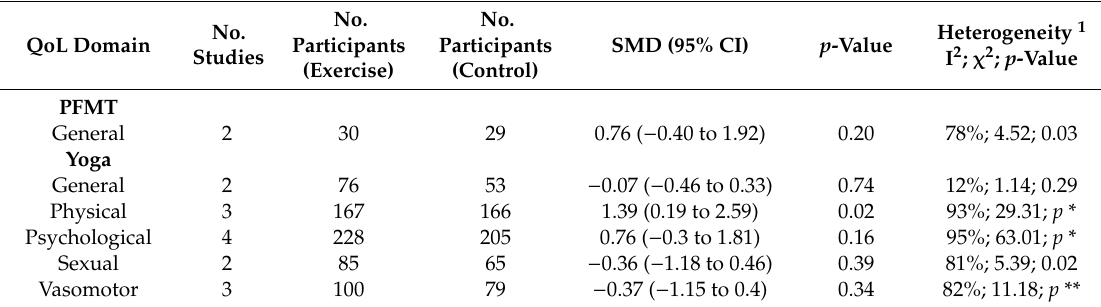
Table 3. Meta-analyses of the e ff ects of PFMT and yoga on QoL domains.